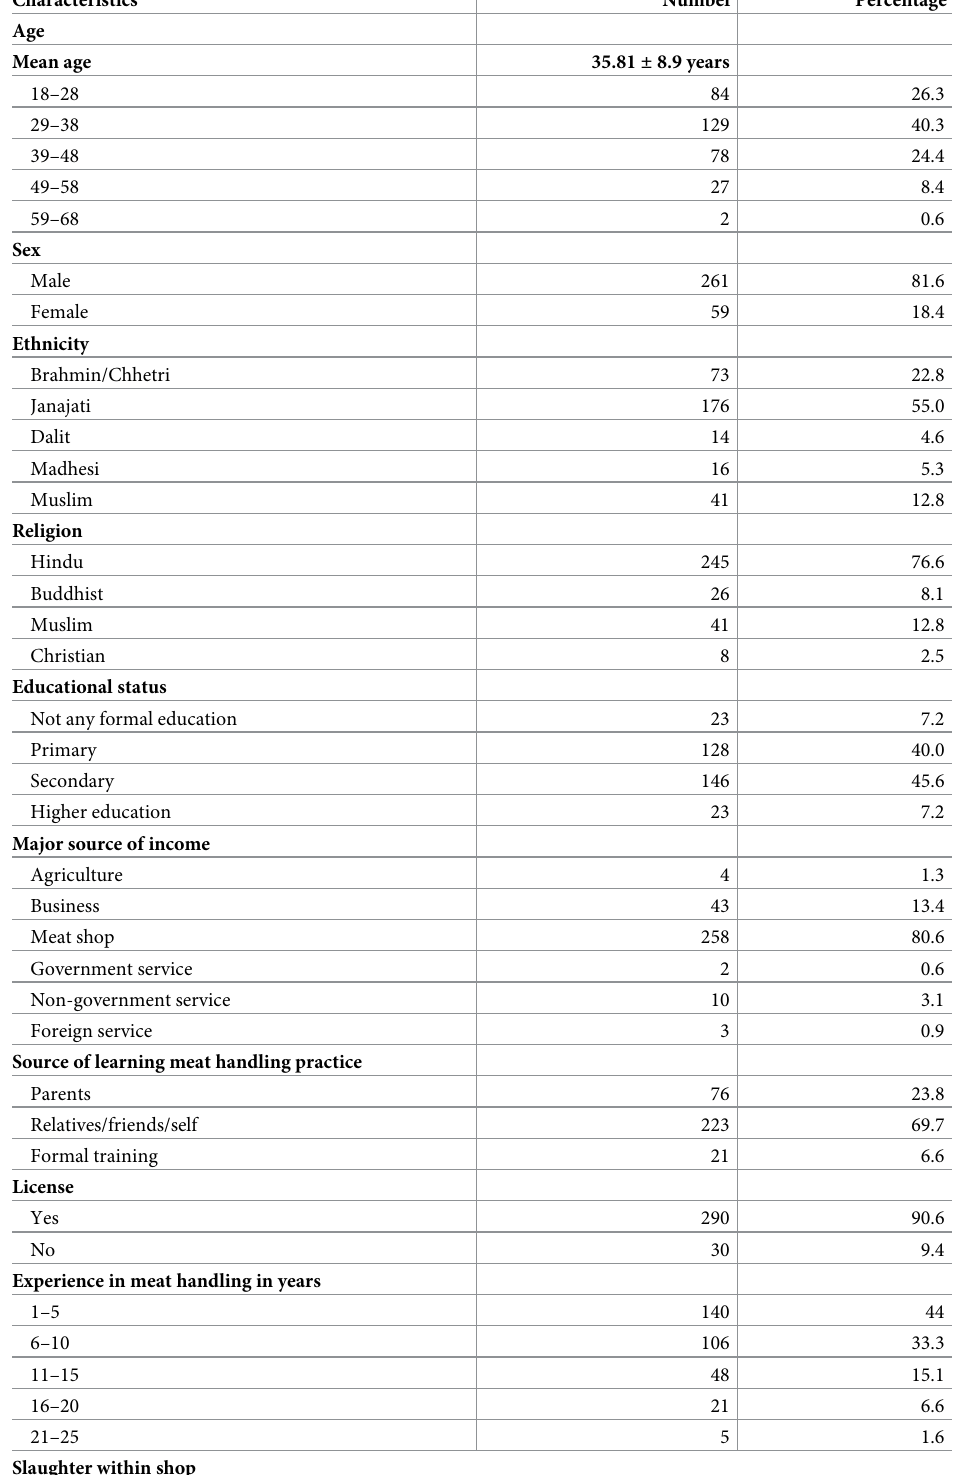
Table 1. Distribution of participants by socio-demographic, meat shop and meat handlers related